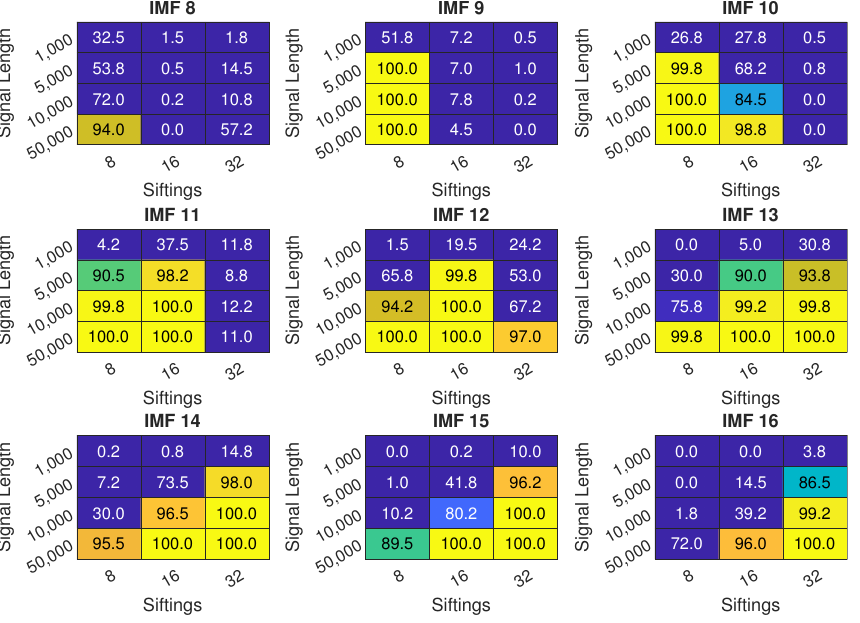
Figure 11. Surge detection accuracy for IMFs 8 to 16 with different signal length N and different number of